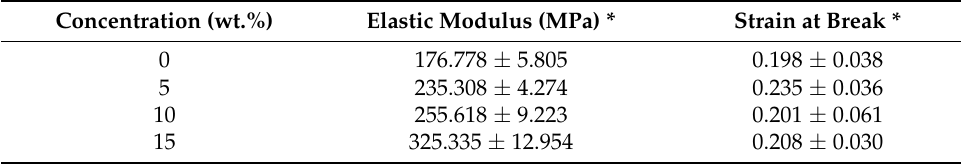
Table 2. Elastic modulus and strain at break with respect to dye